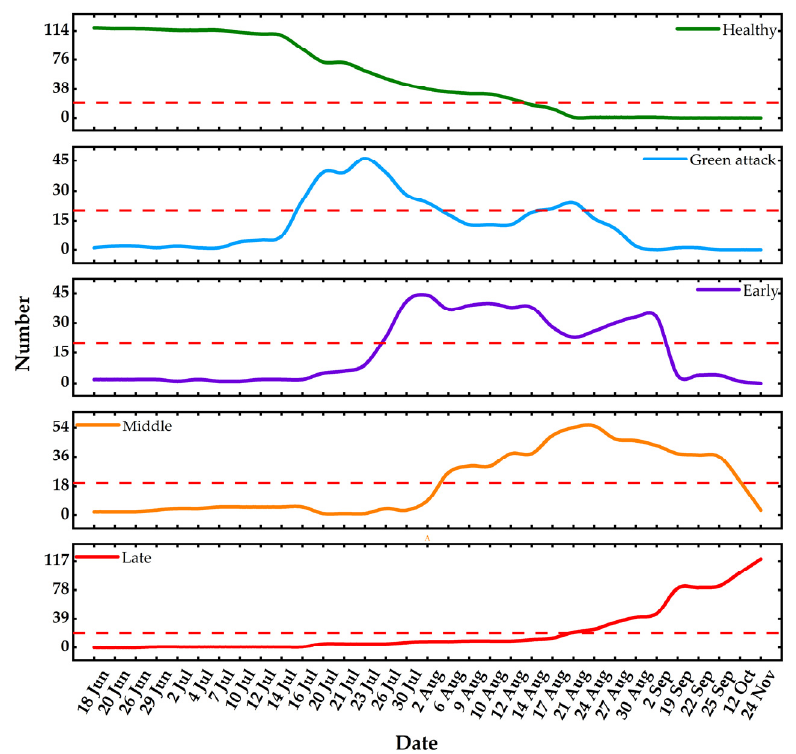
Figure 5. Temporal variation in tree numbers at different infection stages. The red discontinuous line represents that the number is 20.